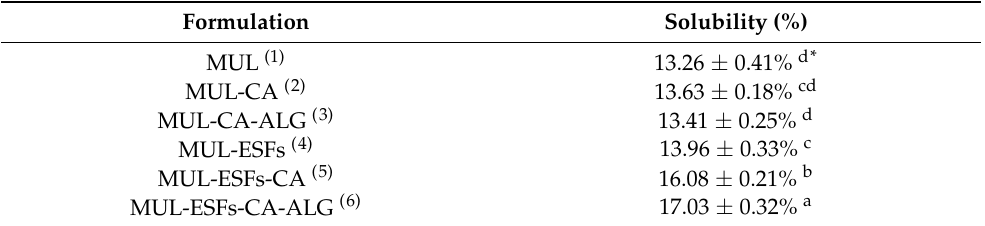
Table 3. Water solubility analysis by rheometer and hot-melt-extrusion of MUL ultrafine powder of different chemical